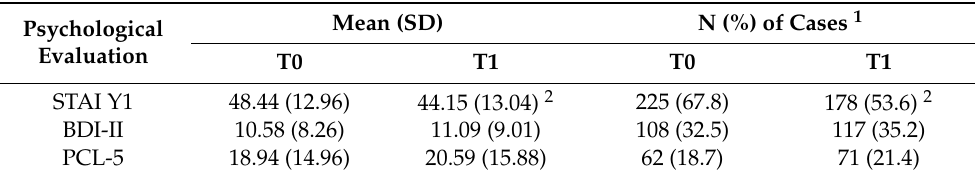
Table 2. Psychological data of the total sample (N = 332). Mean (SD) and number of patients scoring above the cut-off have been reported as cases, at both T0 and T1.